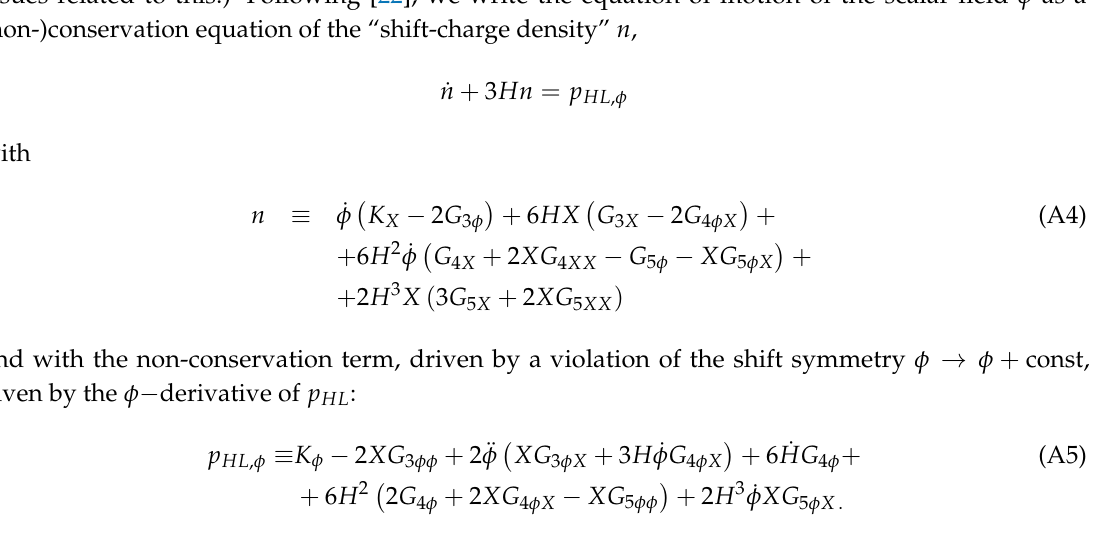
Table A1. Comparison table for the different definition of energy density and pressure of the scalar field.